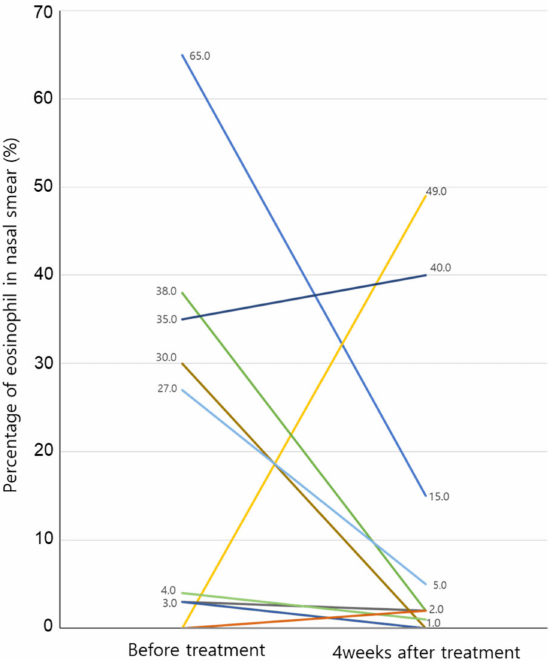
Figure 4. Changes in eosinophils before and after phototherapy with nasal smear. Eosinophilic percentage in the nasal smear is 0% in both tests before treatment and in 10 patients at 4 weeks after treatment. There are two patients who decrease from 3% before treatment to 0% after 4 weeks of treatment, and the results of the remaining patients can be seen in the